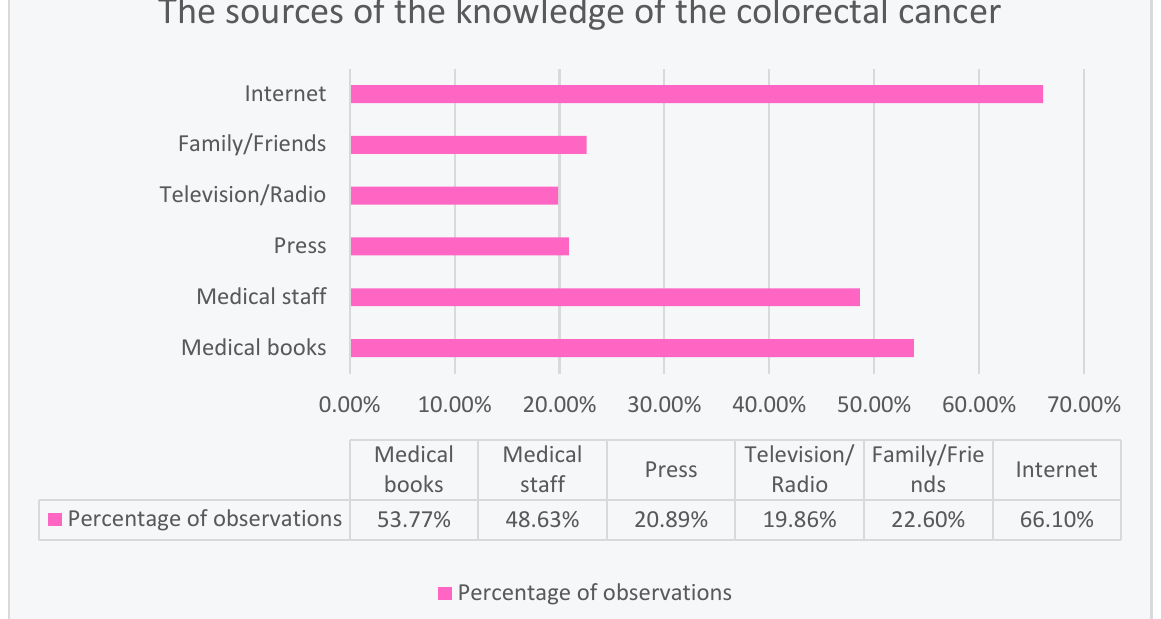
Figure 1. The sources of respondents’ knowledge of the colorectal cancer.